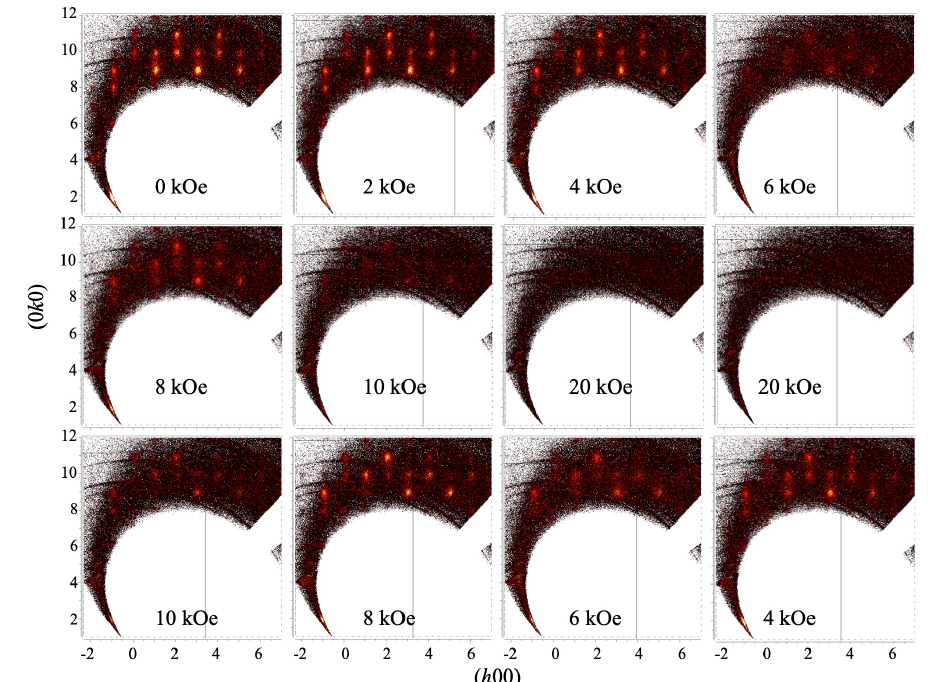
Figure A6: Out-of-plane scattering for different fields applied along to the c axis at T = 60 mK. Top panel illustrates the disappearance of the ( h k above 10 kOe and its restoration when the field is